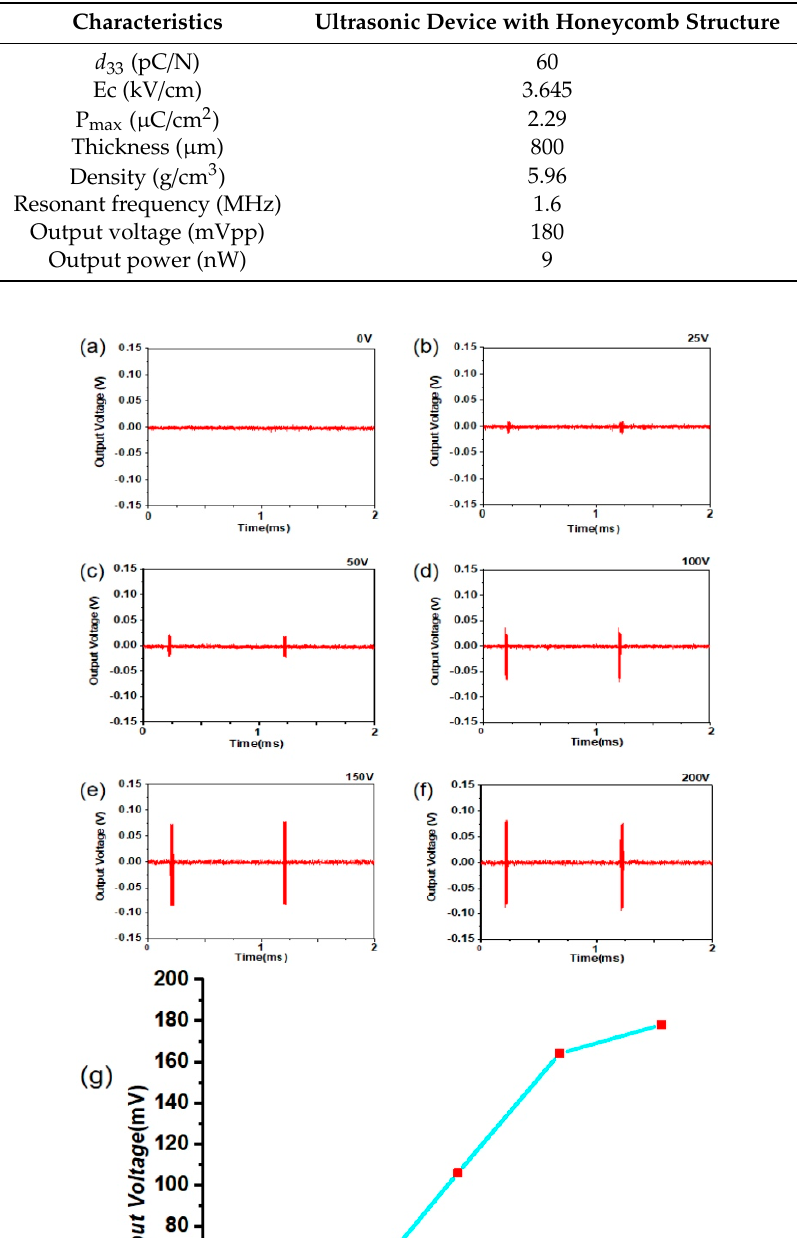
Table 2. Performance parameters of the ultrasonic device.